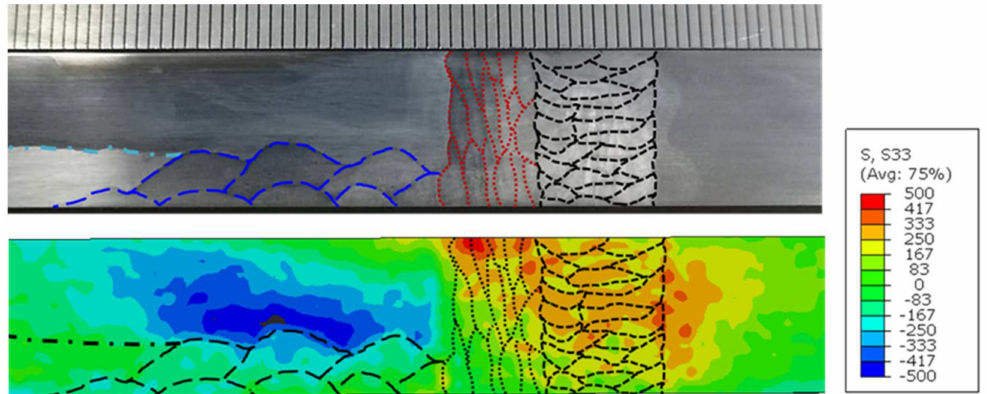
Figure 12. Hoop residual stress (MPa) distribution obtained using the contour method: top —macrograph of the DMW joint, in which the cladding, buttering and the multi-pass girth weld areas are respectively marked with blue, red and black dotted lines; bottom —the contour plot of the hoop residual stress, in which the corresponding regions are also marked with dotted